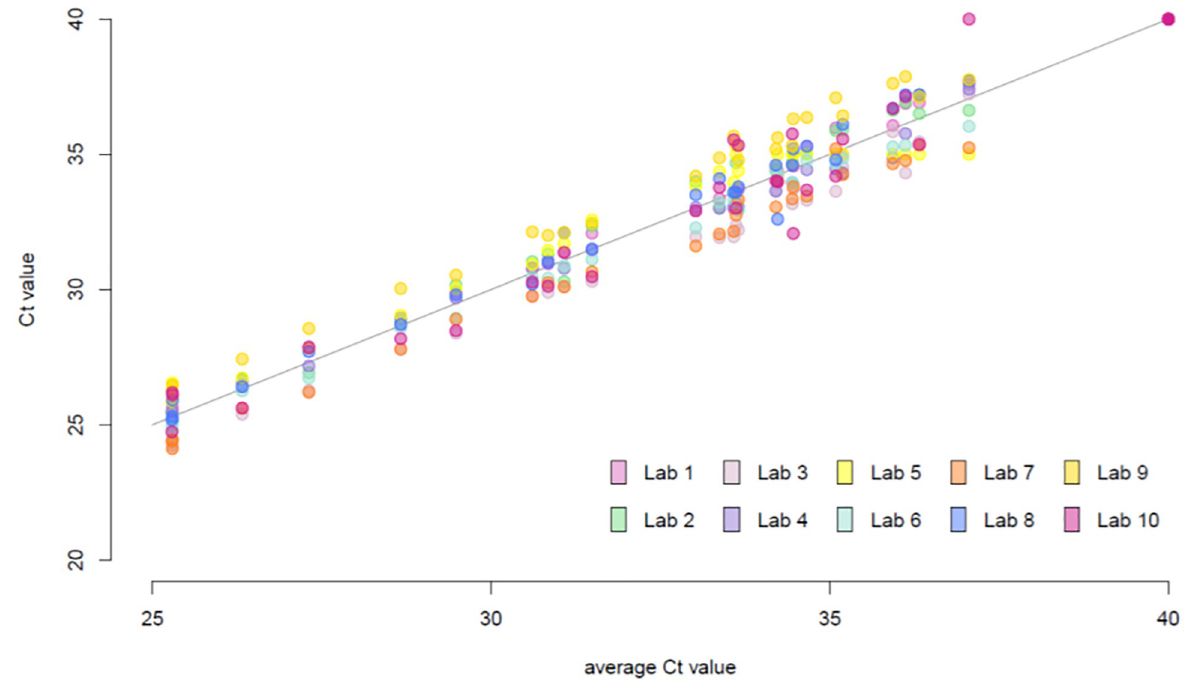
Fig 3. High interlaboratory agreement in C t values for blinded clinical samples in Project B. C t values plotted against the sample-specific average C t values from the 10 laboratories. The solid line indicates the line of equation y = x . Each color indicates one laboratory; the same color is used to identify each laboratory in all subsequent figures.